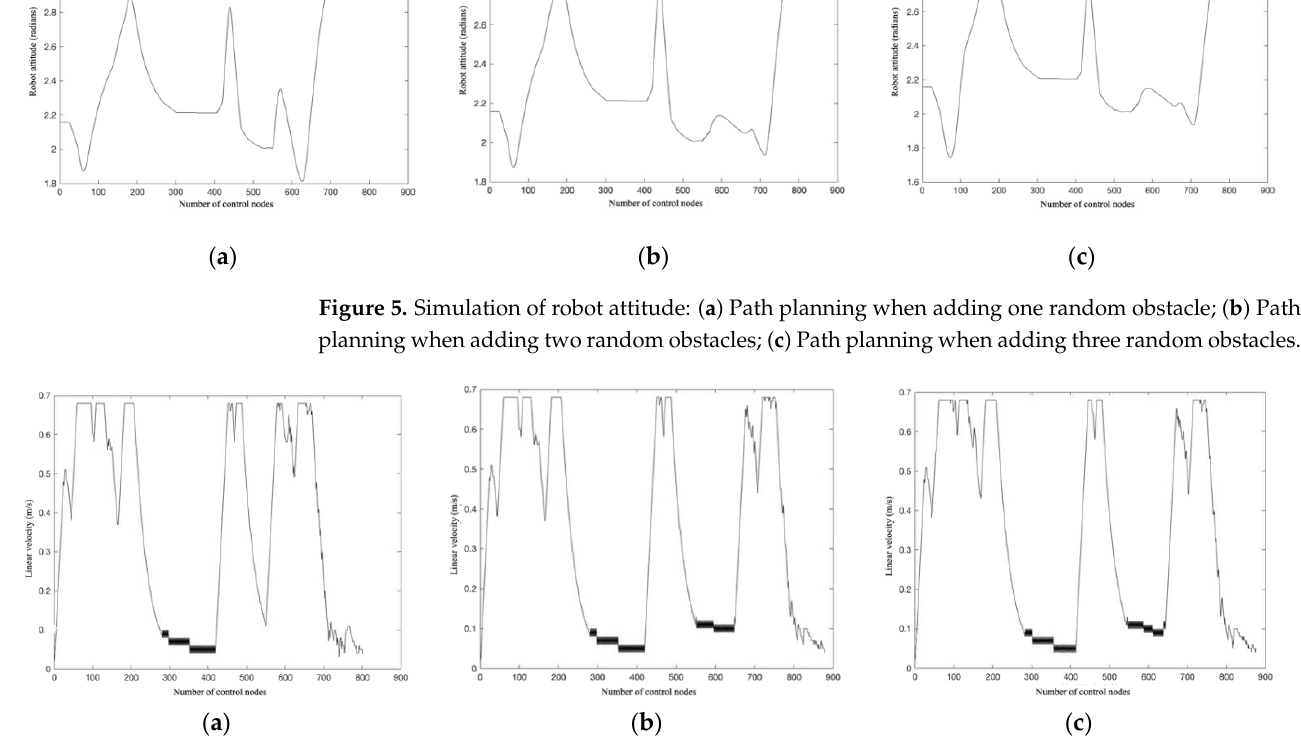
Figure 6. Simulation of changes in the line velocity of robots: ( a ) Path planning when adding one random obstacle; ( b ) Path planning when adding two random obstacles; ( c ) Path planning when adding three random obstacles.